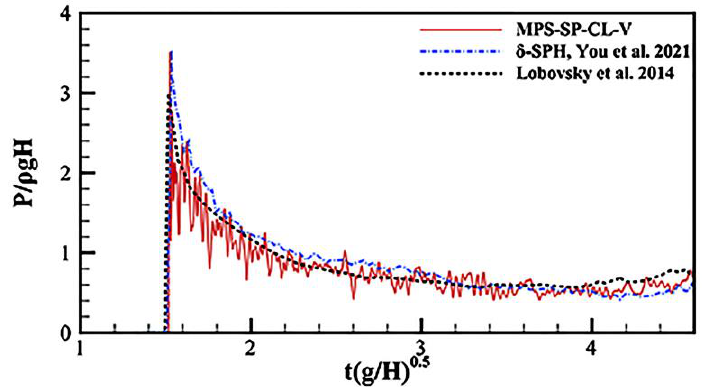
Figure 15. Pressure curves of point B1 calculated by MPS-SP-CL-V and the δ -SPH method ( l 0 = 0.005 m). The curves of the δ -SPH method and the experiment are from You et al. [43] and Lobovsk ý et al. [42], respectively.